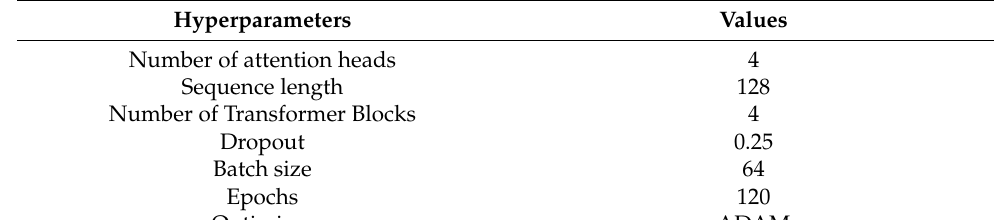
Table 3. Model hyperparameters.